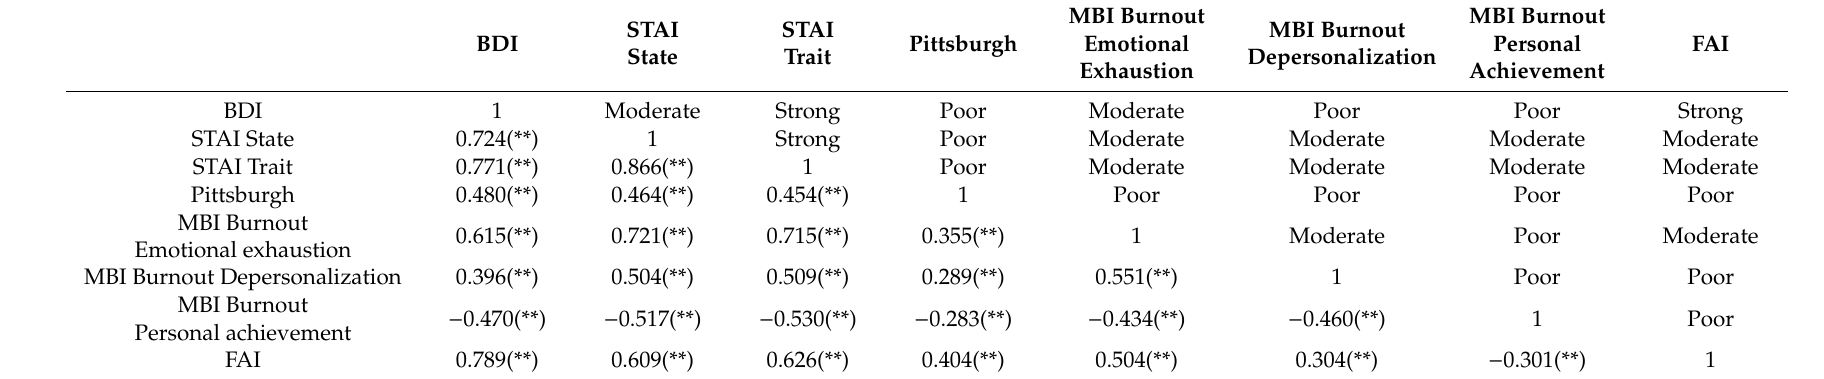
Table 2. Pearson’s correlations in the total number of participants.